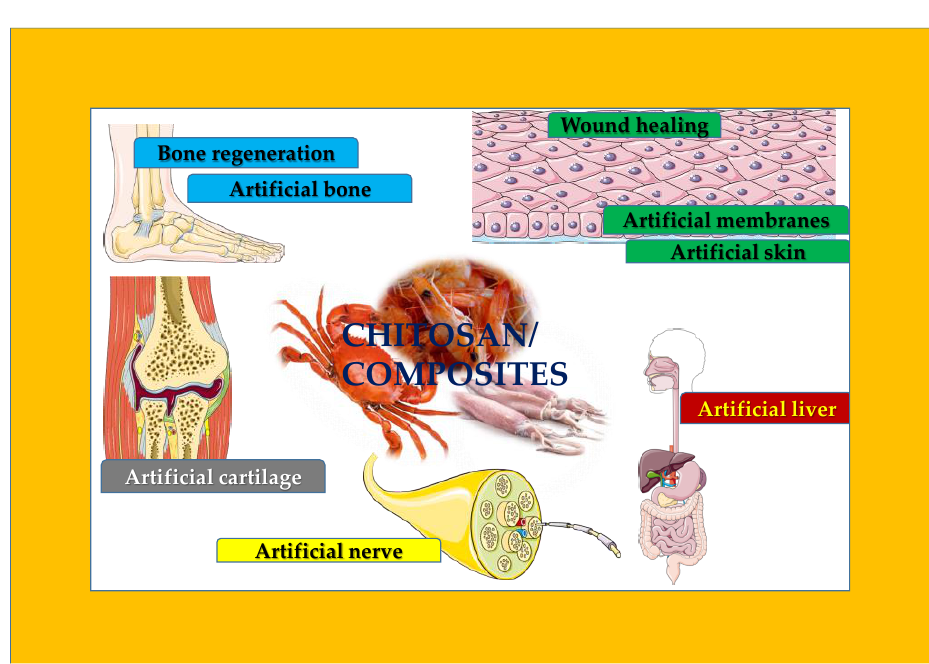
Figure 2. Overview of the areas impacted by chitosan and its composites.